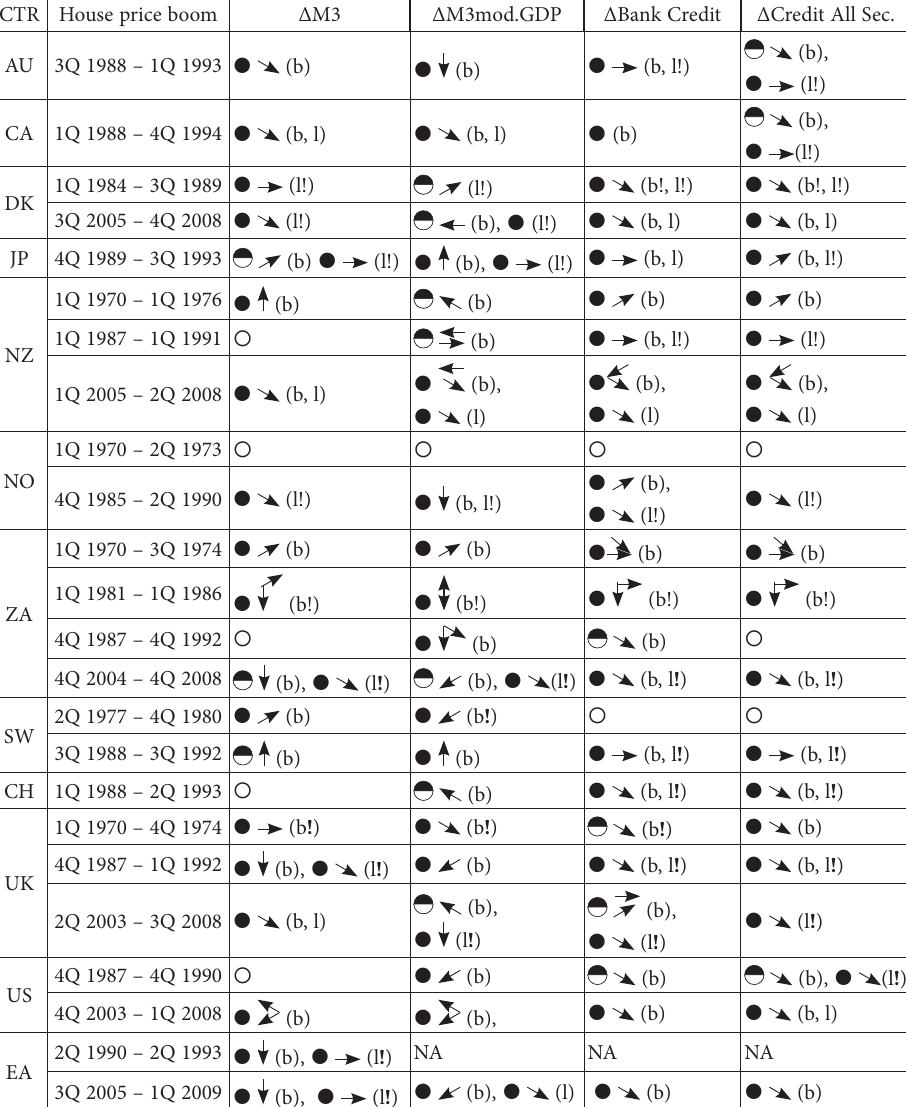
Table 3. Co-movements and causality between financial variables and house price inflation during house price booms (1970 and 2016) (source: own work) CTR House price